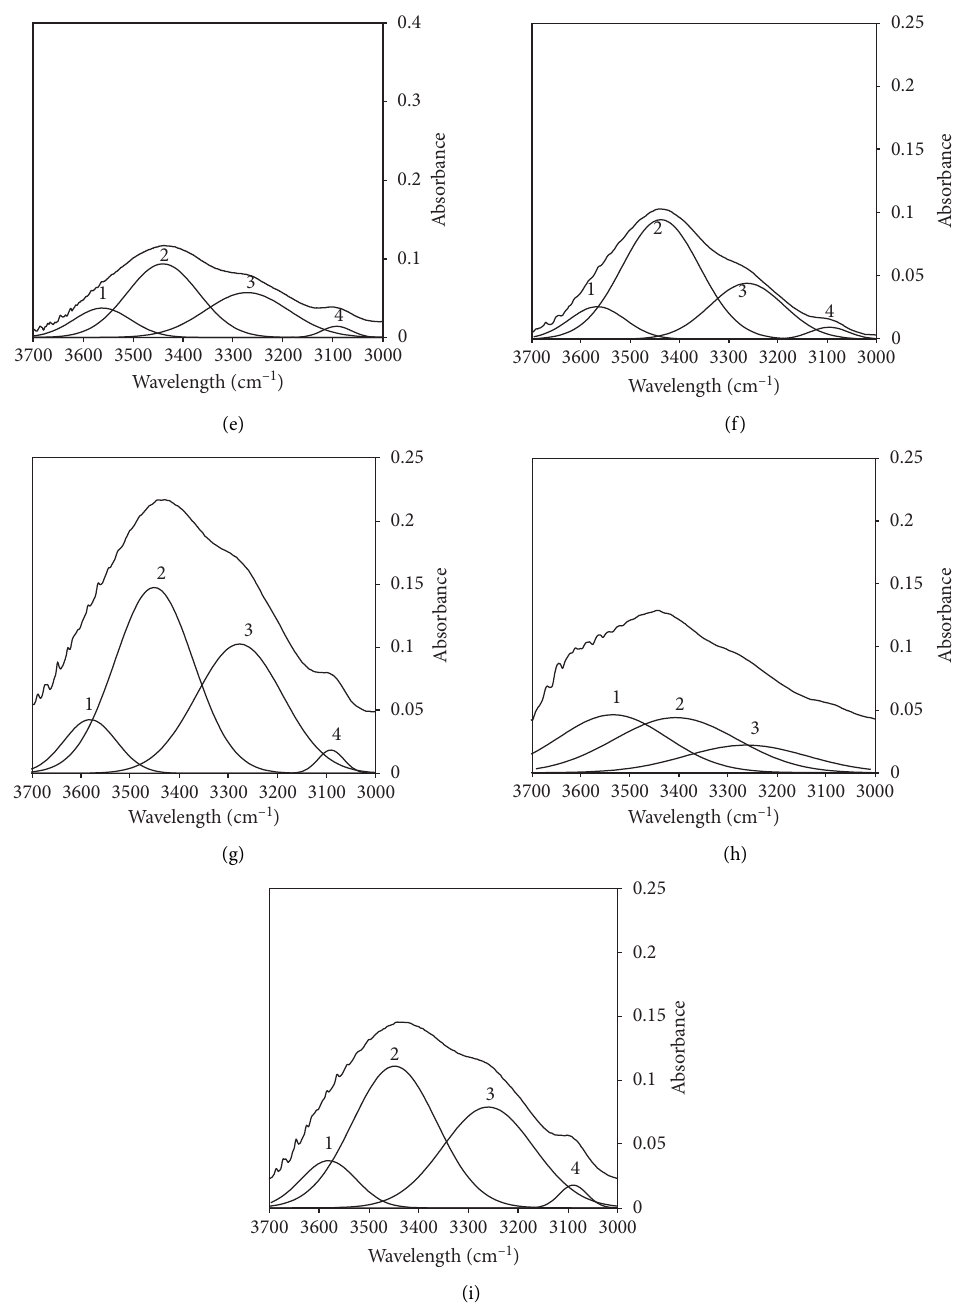
Figure 9: Deconvolution FT-IR spectra of (a) the extracted chitin and chitin hydrogel of (b–e) C1-3 to C1-10 and (f–i) C2-3 to